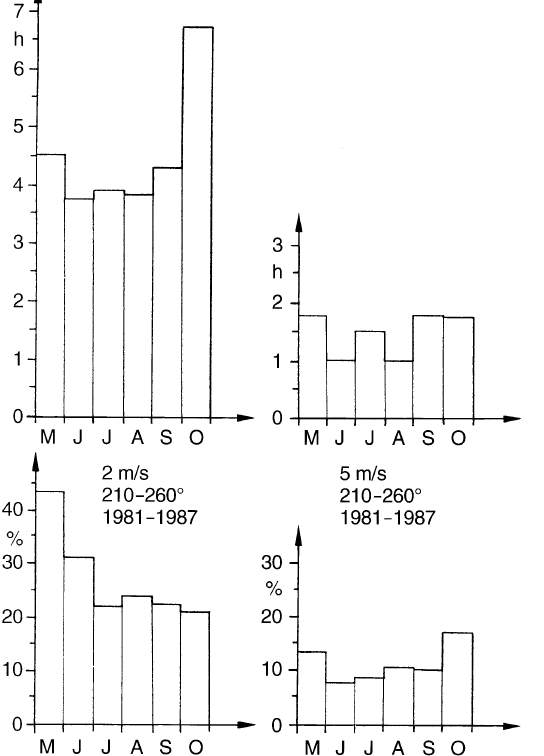
Fig. 8. The event structure of winds from the sector 210 ° to 260 ° (SW; ‘vent’) recorded at CO over the 6 year period 1981 — 1987 and segmented into monthly subsets. Two classes of wind speed were analyzed: (a) winds above 2 m s (cid:126)(cid:49) and (b) winds above 5 ms (cid:126)(cid:49) . For each class the diagrams shown are: top : mean monthly duration of event; bottom : mean monthly occurrence of events